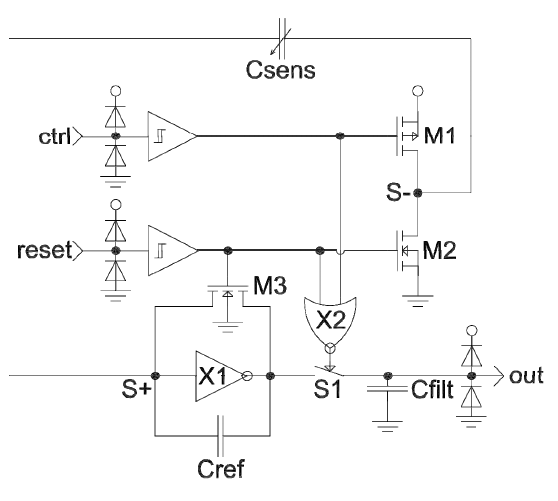
Figure 3. Schematic of the CMOS humidity sensor.